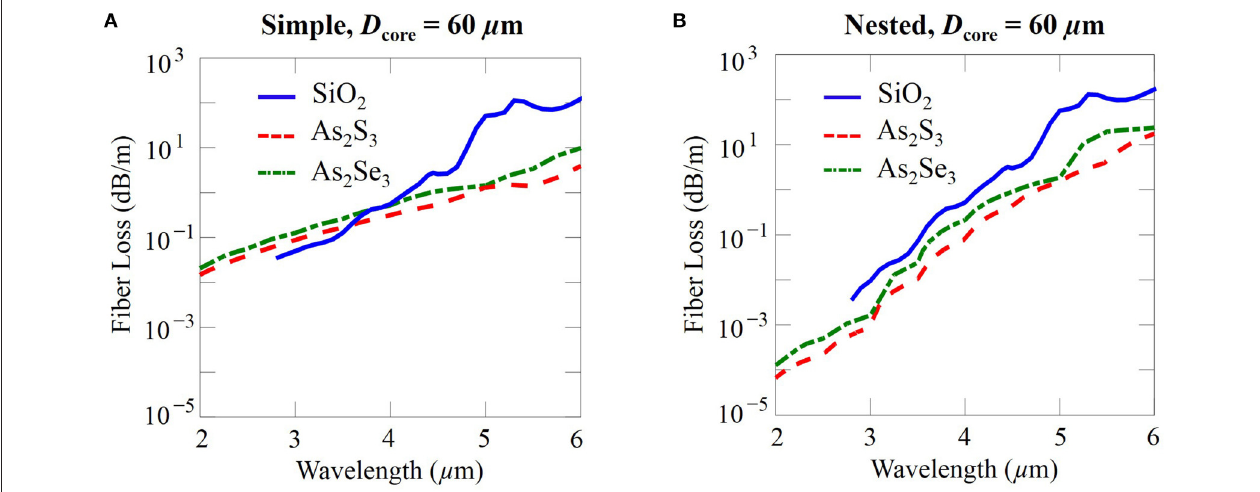
FIGURE 12 | Fiber loss of (A) simple and (B) nested negative curvature fibers made with silica, As 2 S 3 chalcogenide, and As 2 Se 3 chalcogenide glasses with a fixed core diameter of D core = 60 µ